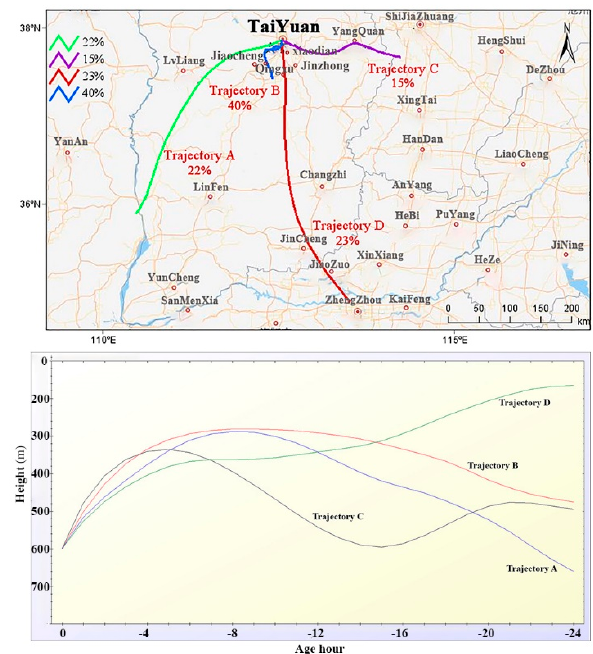
Figure 14. Result of cluster analysis of backward trajectory of airflow when O 3 exceeded standard in Taiyuan City from April to August 2018.